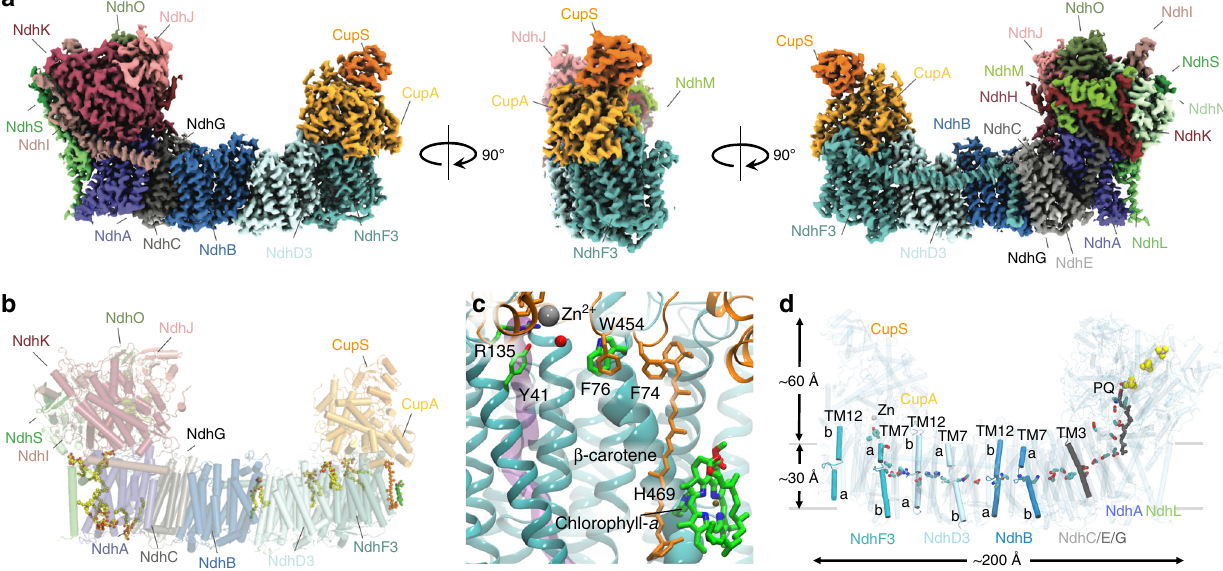
Fig. 1 Structure of the carbon-concentrating photosynthetic complex I. a The electron density map of NDH-1MS (NDH-1 3 ) shown from a back view (left), side view (middle), and front view (right). b Experimentally re fi ned lipid molecules and cofactors in the hydrophobic domain of NDH-1MS. c The structure of the Chl a / β -carotene motif of NdhF3 that connects to the active site of CupA. See Supplementary Fig. 3 for example densities. d Chain of charged elements transmitting the redox-signal into proton pumping and CO 2 uptake. The PQ was computationally modelled into the experimental structure.